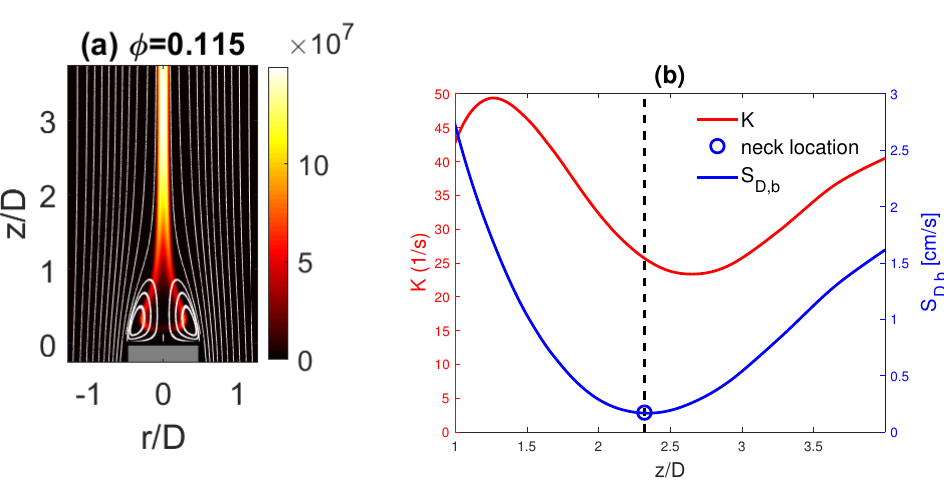
Figure 8. ( a ) Heat release contour for near extinction flame at φ = 0.115; ( b ) Local stretch rate and displacement speed as a function of axial length. Neck location is identified with ◦ symbol on the displacement speed